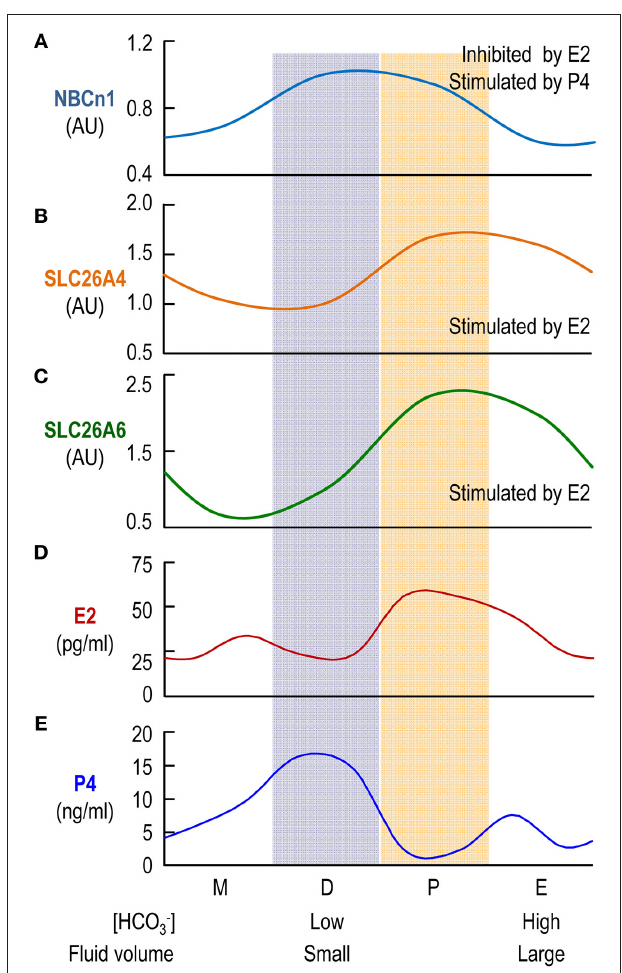
FIGURE 7 | Comparison of profiles of protein abundances of uterine HCO − 3 transporters and plasma levels of β -estradiol and progesterone. The profiles for the relative protein levels of NBCn1 (A) , SLC26A4 (B) , SLC26A6 (C) are fitted based upon the data shown in Figure 3 . The profiles of the blood plasma β -estradiol (E2; D ) and progesterone (P4; E ) are plotted based upon the previously reported data ( Walmer et al.,